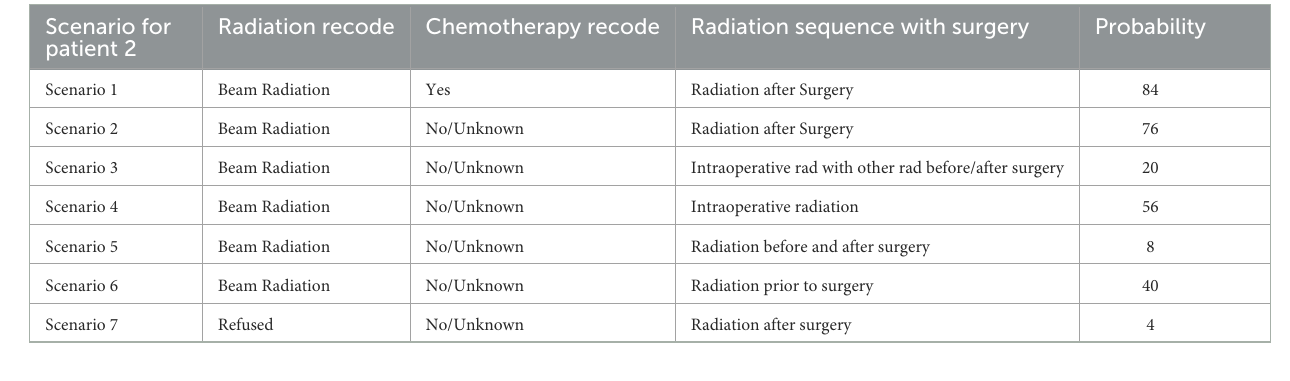
TABLE 9 Scenarios for Patient_2.